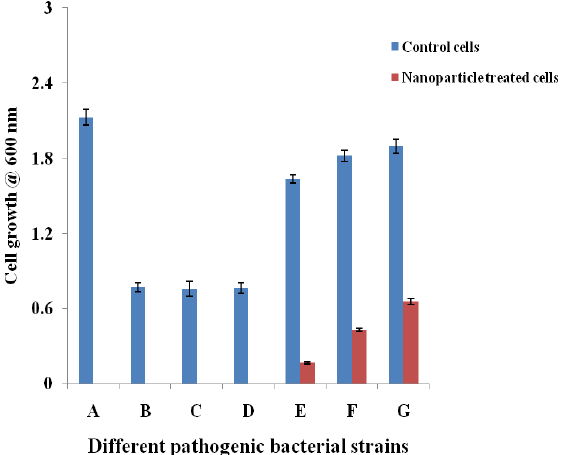
Figure 8. The cell suspension inhibition properties of silver nanoparticles derived from marine